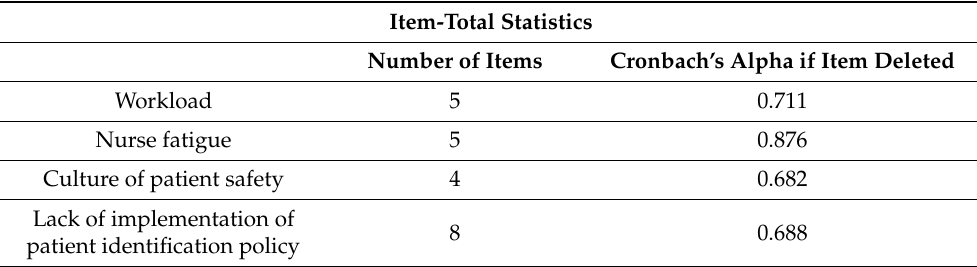
Table 8. Cronbach’s alpha coefficients for other factors affecting healthcare service.